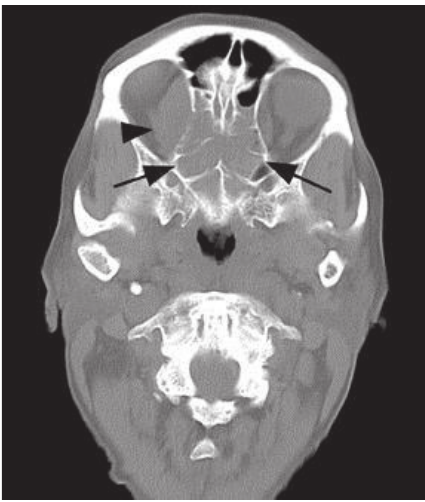
Figure 1: Axial noncontrast brain CT (bone algorithm image) showing a large sinonasal mass involving the ethmoid/sphenoid minuses (arrows) with right orbital extension (arrowhead).